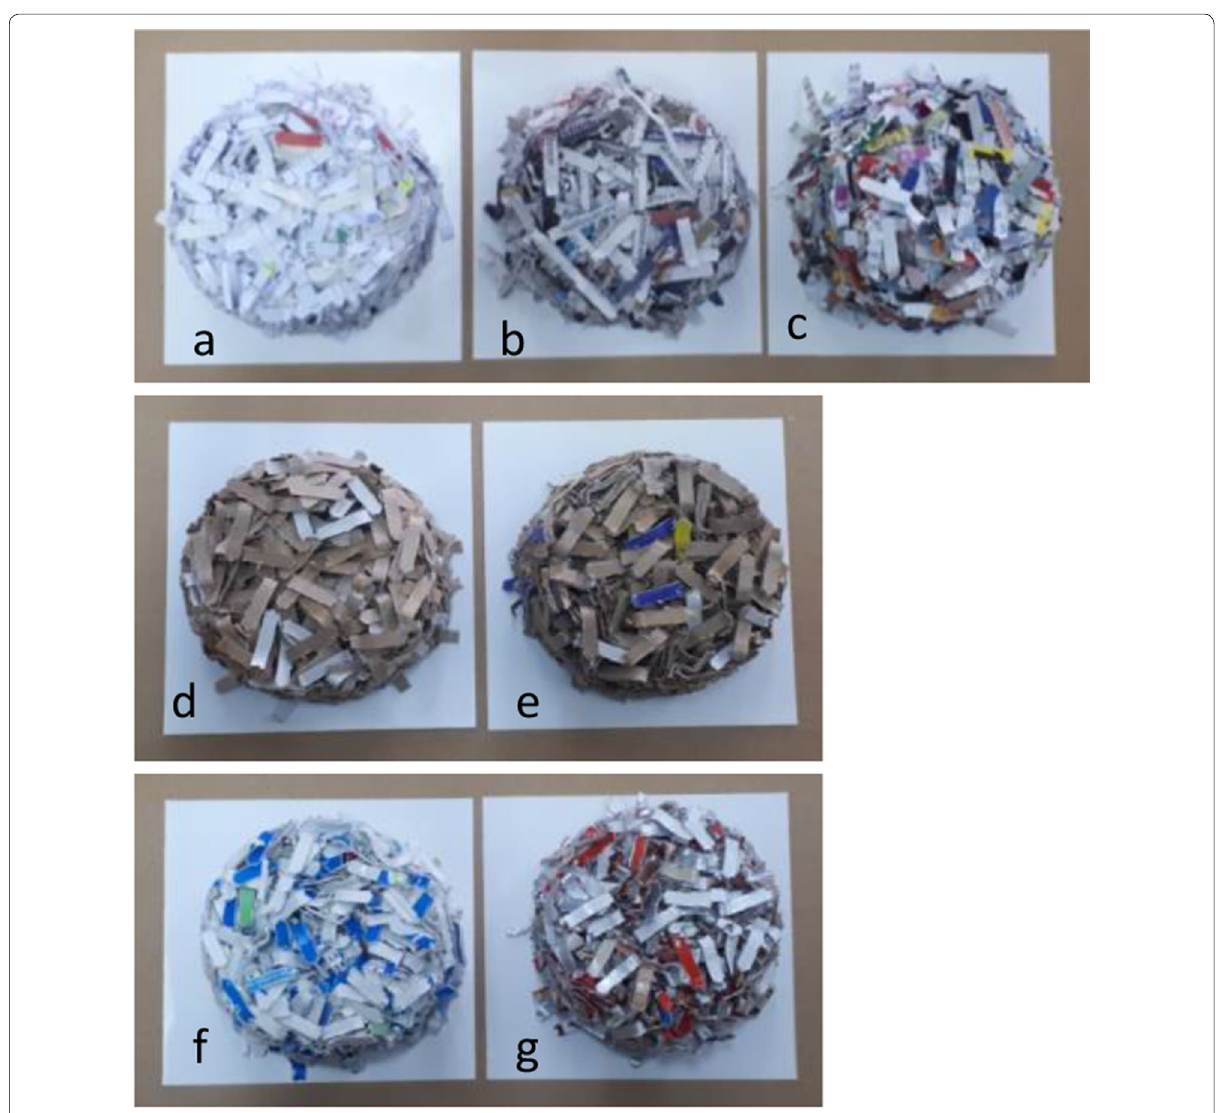
Fig. 1 Filling materials: a office paper, b newspaper, c magazine paper, d testliner, kraftliner and fluting papers, e paperboard, f Tetra Pak I, g Tetra Pak